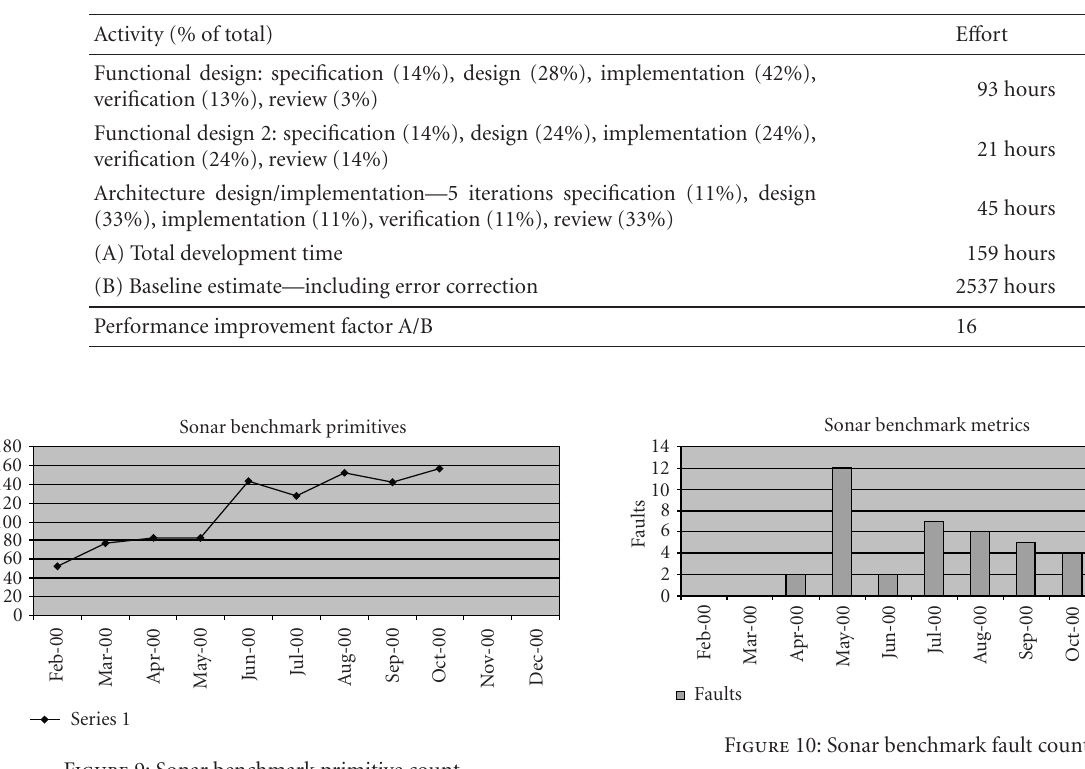
Figure 9: Sonar benchmark primitive count.